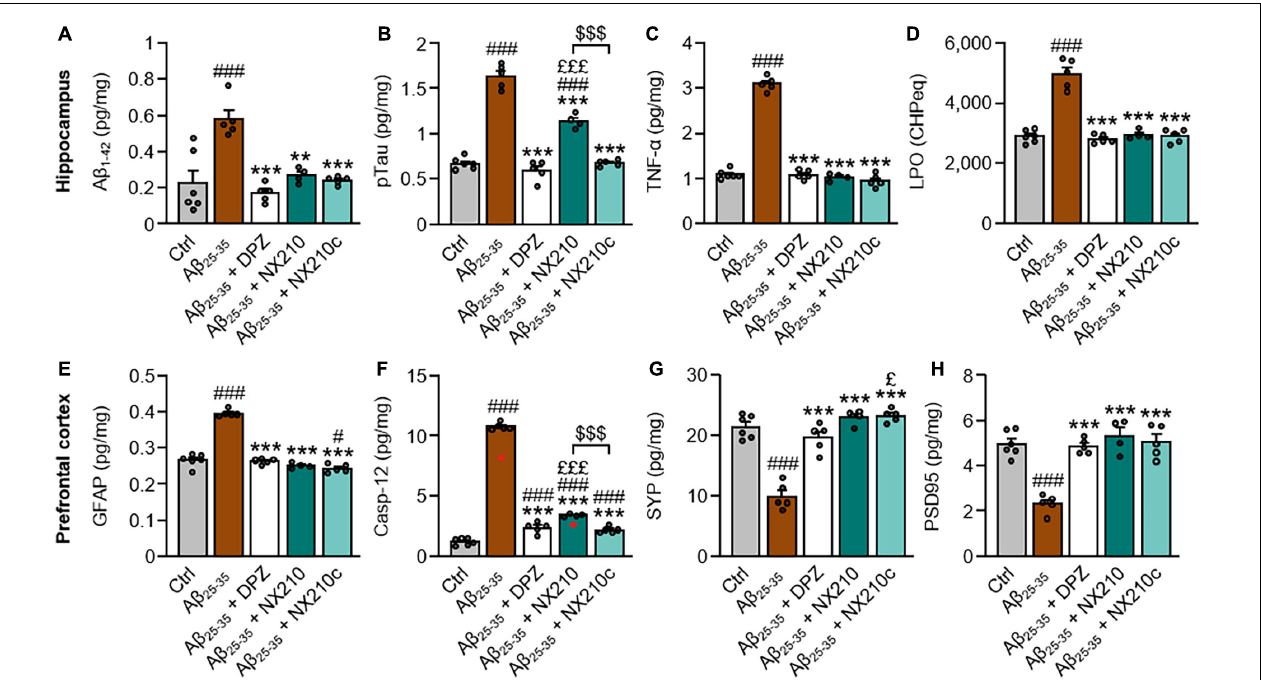
FIGURE 2 | Early stage daily treatment with NX210 or NX210c reduces pathological hallmarks of Alzheimer’s disease. Mice were treated intraperitoneally once a day with vehicle, NX210 or NX210c (2 mg/kg), or orally with donepezil (DPZ, 1 mg/kg) one hour after intracerebroventricular injection of scrambled control peptides (Ctrl) or amyloid-beta 25 - 35 (A β 25 - 35 ) oligomers. They were sacrificed at day 11 (D11) and cerebral structures [hippocampi (A–D) and prefrontal cortices (E–H) ] were collected for biochemical analyses of levels of A β 1 - 42 ( A ; ELISA), phosphorylated-tau on threonine 181 [pTau; ( B ; ELISA)], tumor necrosis factor- α [TNF α ; ( C ; ELISA)], lipid peroxidation [LPO; ( D; measure of cumene hydroperoxide (CHP) absorbance)], glial fibrillary acidic protein [GFAP; ( E ; ELISA ) ], caspase-12 [Casp-12; ( F ; ELISA)], synaptophysin [SYP; ( G ; ELISA)] and postsynaptic density protein 95 [PSD95; ( H ; ELISA)]. NX210 and NX210c decreased the levels of all those pathological hallmarks of AD and increased synaptogenesis. The data are expressed in CHP equivalents (CHPeq) per wet weight of tissue (D) or in pg per mg of tissue ( other items ) and presented as means and SEM. One-way ANOVA followed by Tukey’s multiple comparisons test: ### p < 0.001, # p < 0.05 compared with Ctrl; *** p < 0.001, ** p < 0.01 comp ared with A β 25 - 35 ; £££ p < 0.001, £ p < 0.05 compared with A β 25 - 35 + DPZ; $$$ p < 0.001 A β 25 - 35 + NX210 vs. A β 25 - 35 + NX210c, n = 6 Ctrl, n = 5 A β 25 - 35 , A β 25 - 35 + DPZ, A β 25 - 35 + NX210c, n = 4 A β 25 - 35 + NX210. These analyses do not include two outliers identified for caspase 12 ELISA using the Grubbs test (red circles) ( p < 0.05).